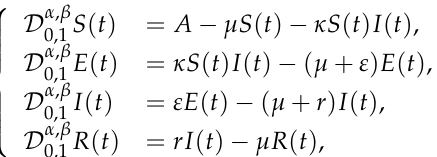
Table 1. Biological meanings of the parameters of model (30). Parameter Biological Meaning A Natality or recruitment rate µ Natural death rate κ Transmission rate of disease ε Transfer rate from class E to class I r Recovery rate of the infectious